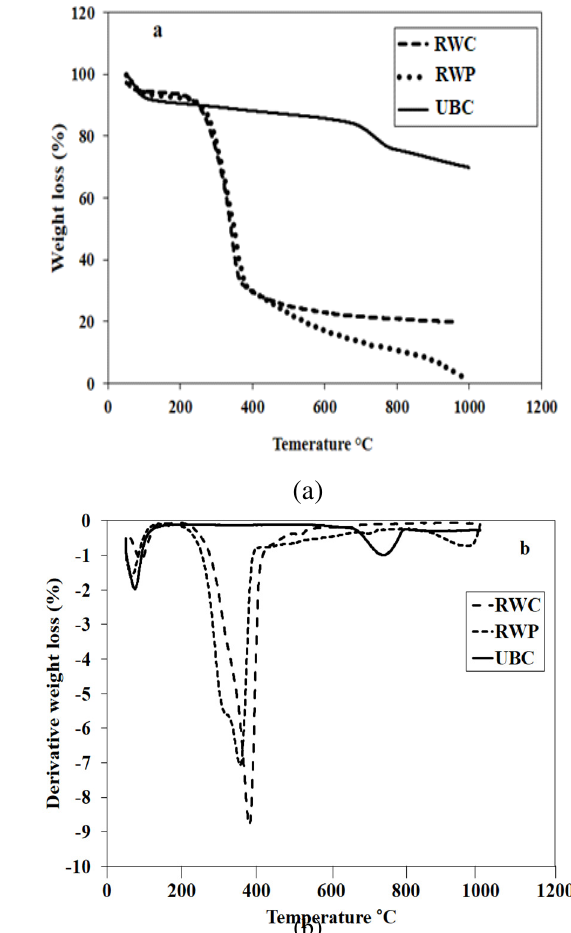
Fig. 5: TGA (a) and DTG (b) profiles of RWC, RWP and